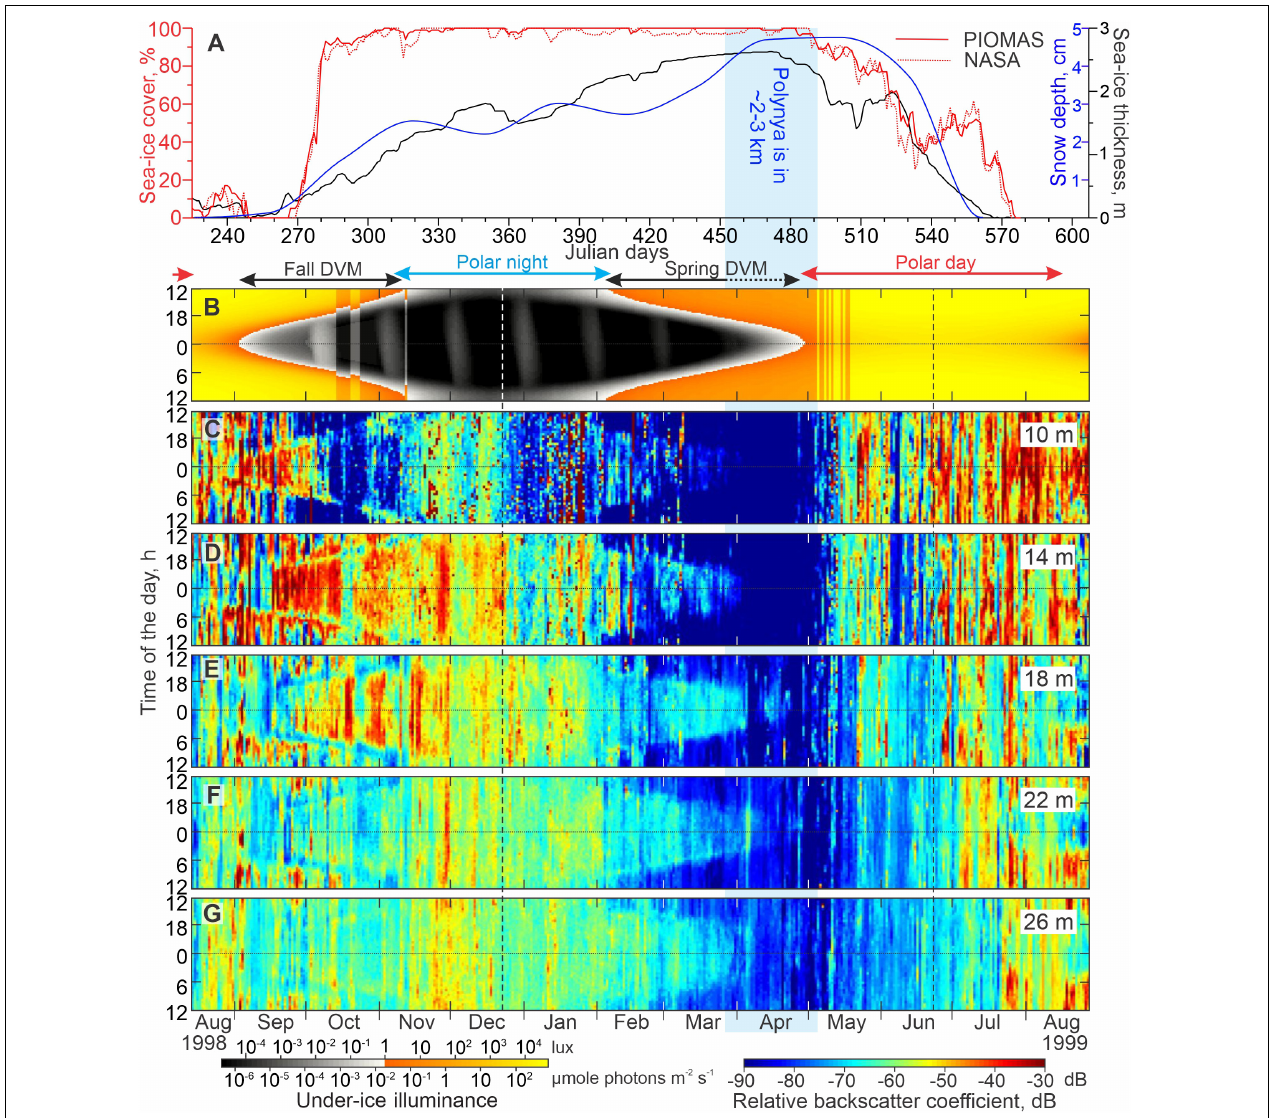
FIGURE 8 | Sea-ice, illuminance, and acoustic backscatter data for mooring Yana. (A) Time series of the snow depth (cm, blue), sea-ice thickness (m, black), and concentrations (%, red) from PIOMAS and NASA (solid and dotted lines, respectively). Actograms of (B) modeled under-ice illuminance (lux) and (C–G) the mean volume backscatter strength (MVBS) (dB) at five depth levels: (C) 10, (D) 14, (E) 18, (F) 22, and (G) 26 m depth. Red, blue and black arrows at the top indicate the periods of polar day, polar night, and diel vertical migration (DVM) of zooplankton, respectively. Dashed black arrow indicates DVM observed only below 18 m depth. Black and white vertical lines depict solstices. Blue shading highlights the coastal polynya ∼ 2–3 km from Yana in March–April